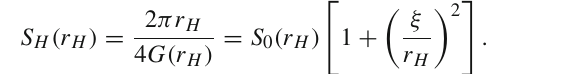
theparameter ξ ,maintainingjusttheleadingcorrection(usingEq.(40)). The color code is as follows: (i) solid black line, for ξ = 0, (ii) dot- ted blue line, for ξ = 0 . 010, (iii) dashed red line, for ξ = 0 . 100, (iv) dot-dashed green line, for ξ = 0 .